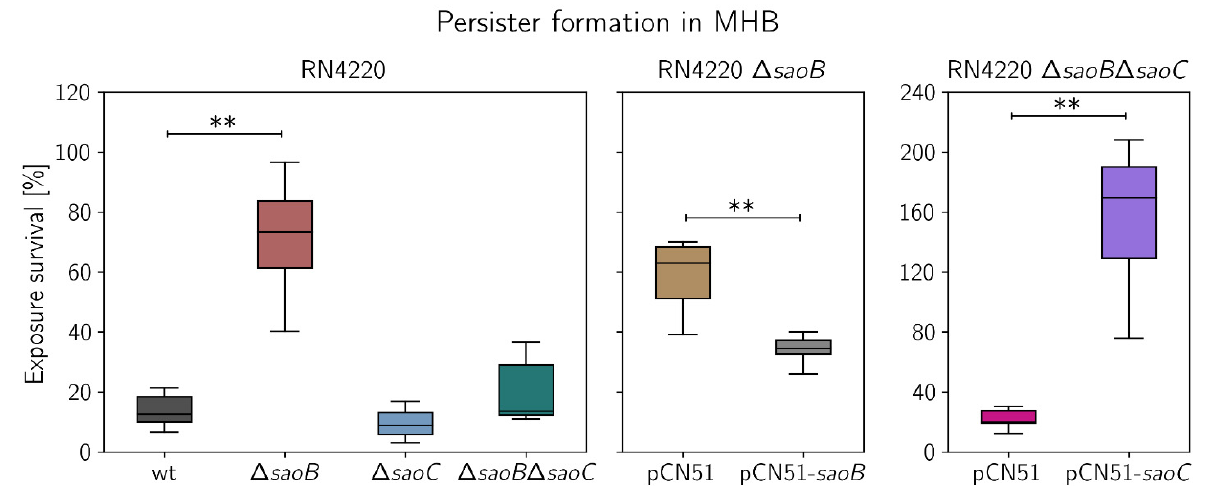
Figure 6. Persister formation by RN4220 strain knockout mutants of saoABC operon genes. Significant differences ( n = 6) are observed only between wild type (wt) RN4220 and RN4220 ∆ saoB (plot on the left). The null mutant is characterised by around 4-fold increased survival during exposure to penicillin. The effect is to some extent reversed by complementation of RN4220 ∆ saoB with pCN51 plasmid vector containing saoB controlled by a cadmium-inducible promoter (plot in the middle). Importantly, no statistically significant increase in survival is observed between the wild type RN4220 and RN4220 ∆ saoC , or the double mutant RN4220 ∆ saoB ∆ saoC (plot on the left). However, cadmium-induced expression of saoC in the double mutant significantly increases persister formation (plot on the right). ** p ≤ 0.010.